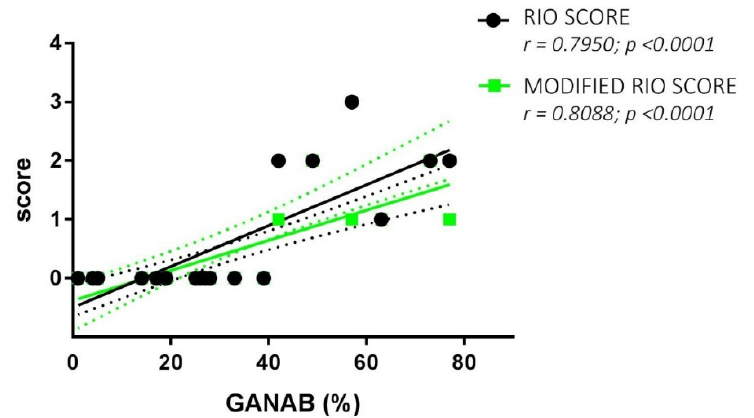
Figure 6. GANAB and RS/MRS correlations. Direct significant correlation between GANAB (%) and Rio Score (green)/Modified Rio Score (black) for the entire cohort of IFN-treated MS patients. Regression lines are shown with the relative standard deviation as dotted lines of the same color.